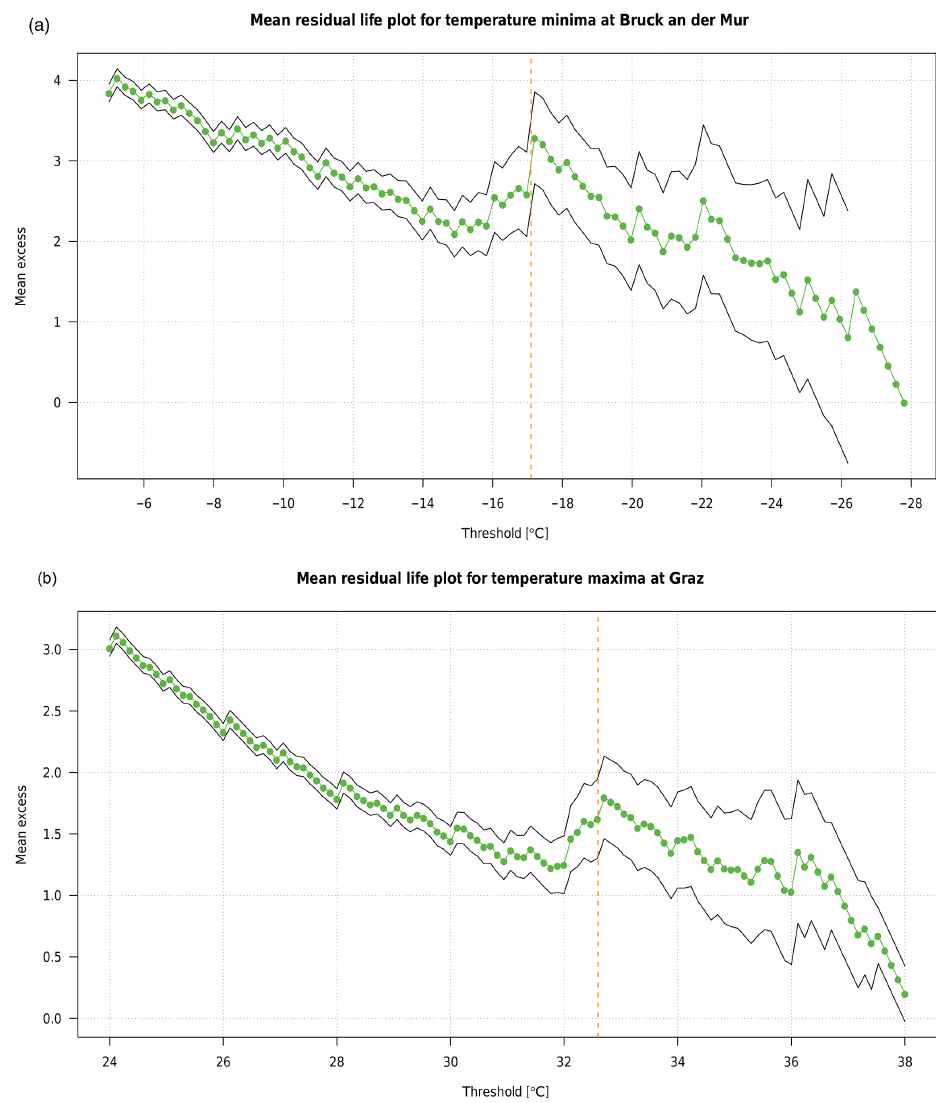
Figure 8. Mean residual life plots of (a) temperature minima the hot spot in Bruck an der Mur and (b) temperature maxima at Graz. Black lines indicate the 95% confidence interval for the mean excess and orange lines indicate the threshold selected by means of the square-root